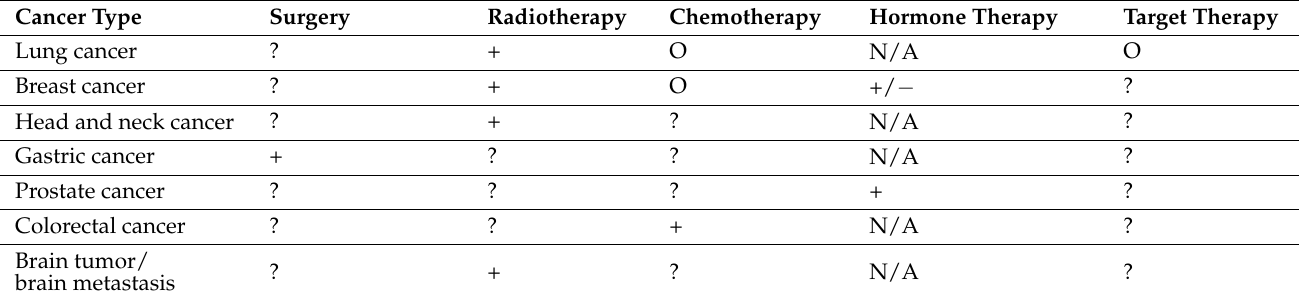
Table 2. The association of cancer and dementia in the clinical